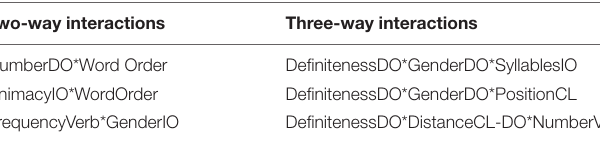
TABLE 2 | Two- and three-way interactions included in the mixed-effects logistic regression model. Two-way